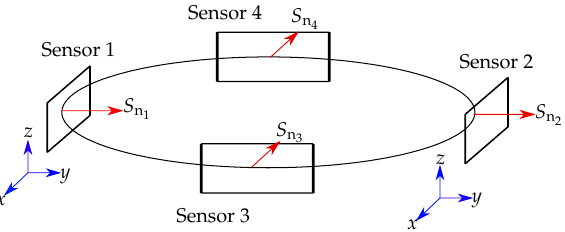
Figure 5. A representative sensor ring with 4 mounted sensors. The normal vector S n for each sensor is depicted. The coordinate systems of sensors corresponding to a pair (Sensor 1 and Sensor 2) are shown in blue.